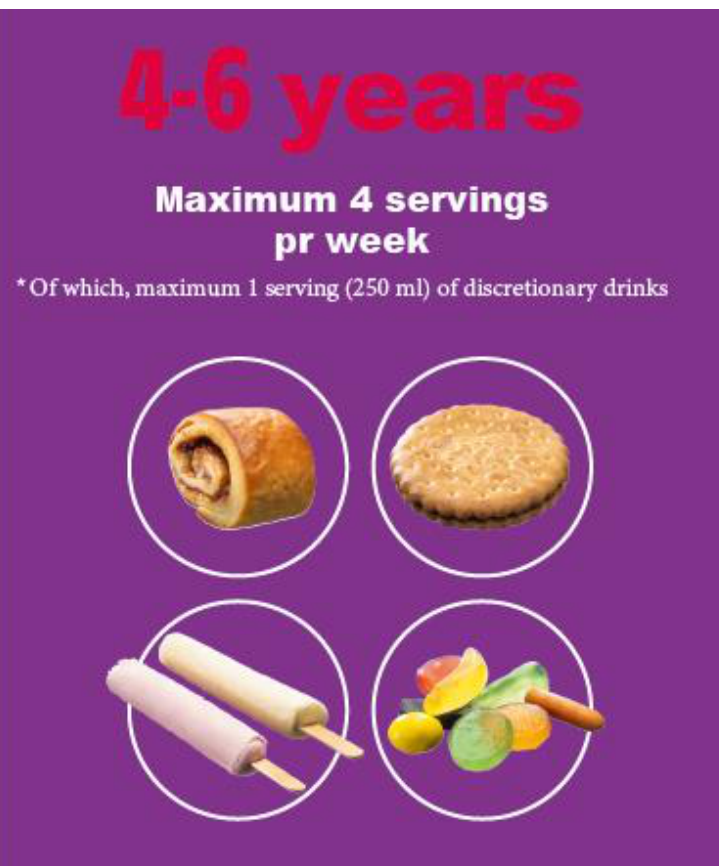
(Figure 1). The definition and development of guidelines for discretionary foods and drinks have been described in more detail elsewhere [1].